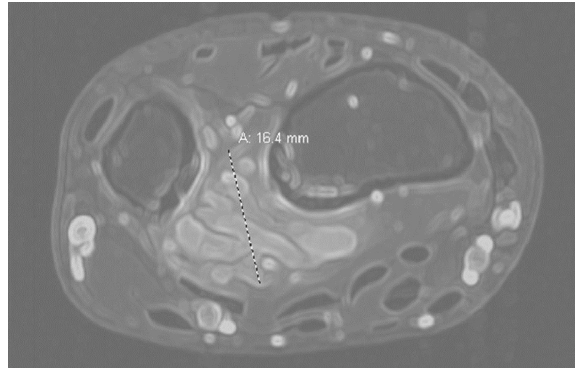
Figure 1: CT scan shows a lobulated 1.6cm vascular mass in the pronator quadratus muscles along the interosseous membrane near the distal radioulnar joint.